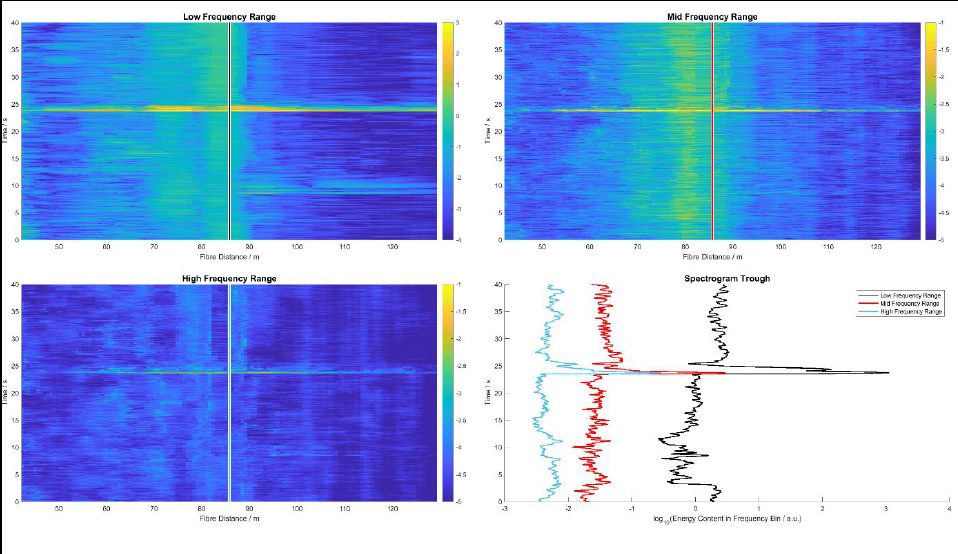
Figure 12. Bandpass analysis of rail break event with a peak when the rail brakes in the overlapped bandpass powers (bottom right).